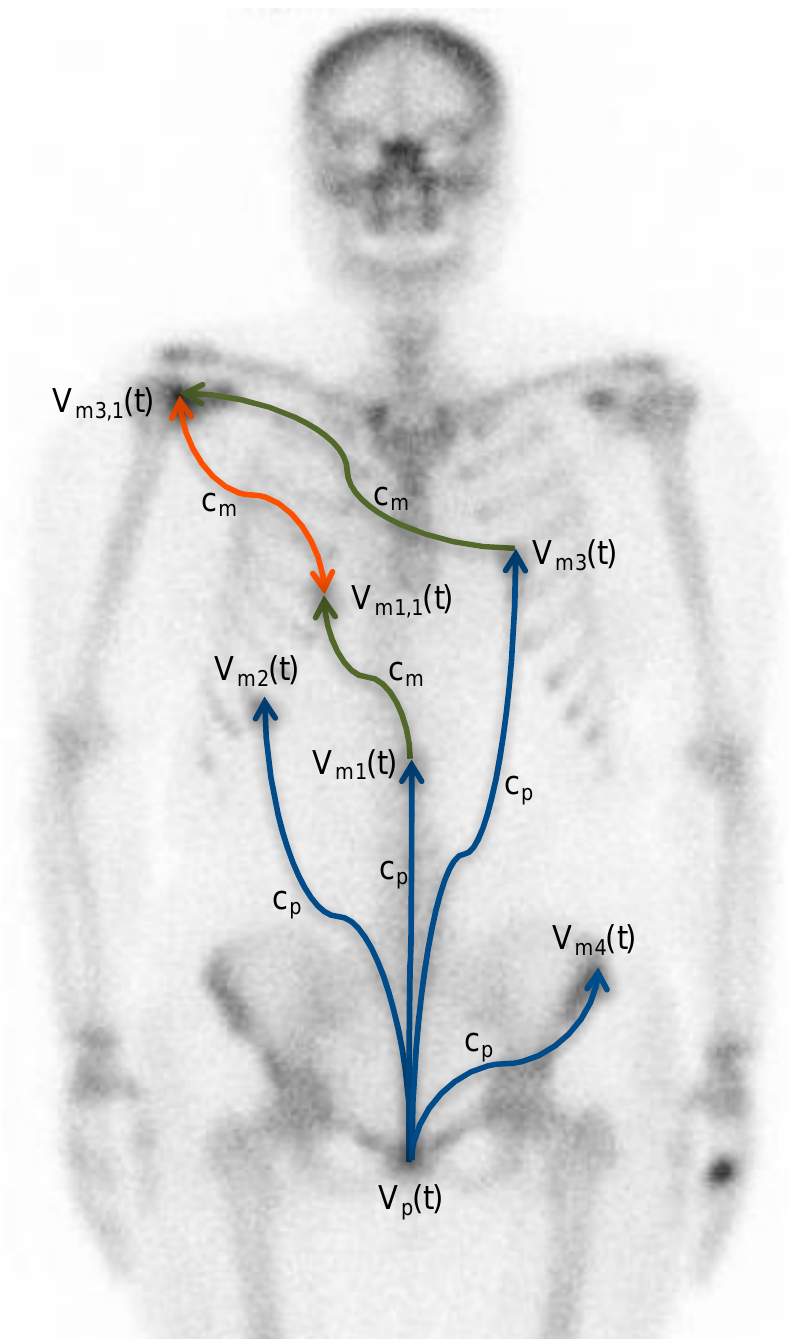
Figure 1. Schematic description of the metastatic dissemination model of prostate cancer. The metastatic formation rate (c p ) depends on the volume of the primary tumor (V p (t)). From the settled metastases (V mi,i (t)), new metastases can be formed at a metastatic formation rate c mi . The blue arrows illustrate the dissemination of metastases from the primary tumor, while the green arrows illustrate dissemination from the metastases. The orange doubled arrow illustrates that tumor cells can be disseminated in any direction into already-established metastases [17].